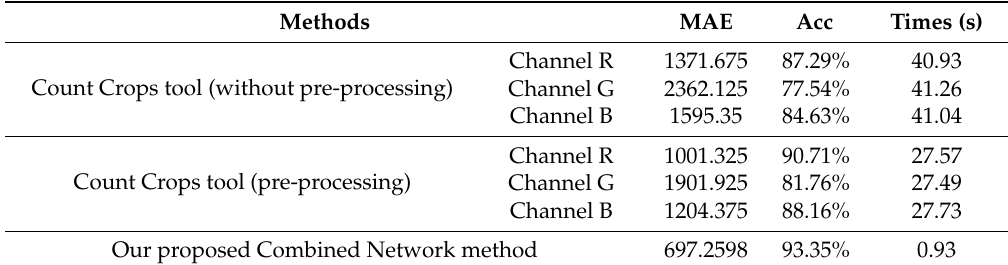
Table 3. Comparing the performance of the Combined Network and the ENVI-5.5 Crop Science platform for counting rice seedlings in the RSC